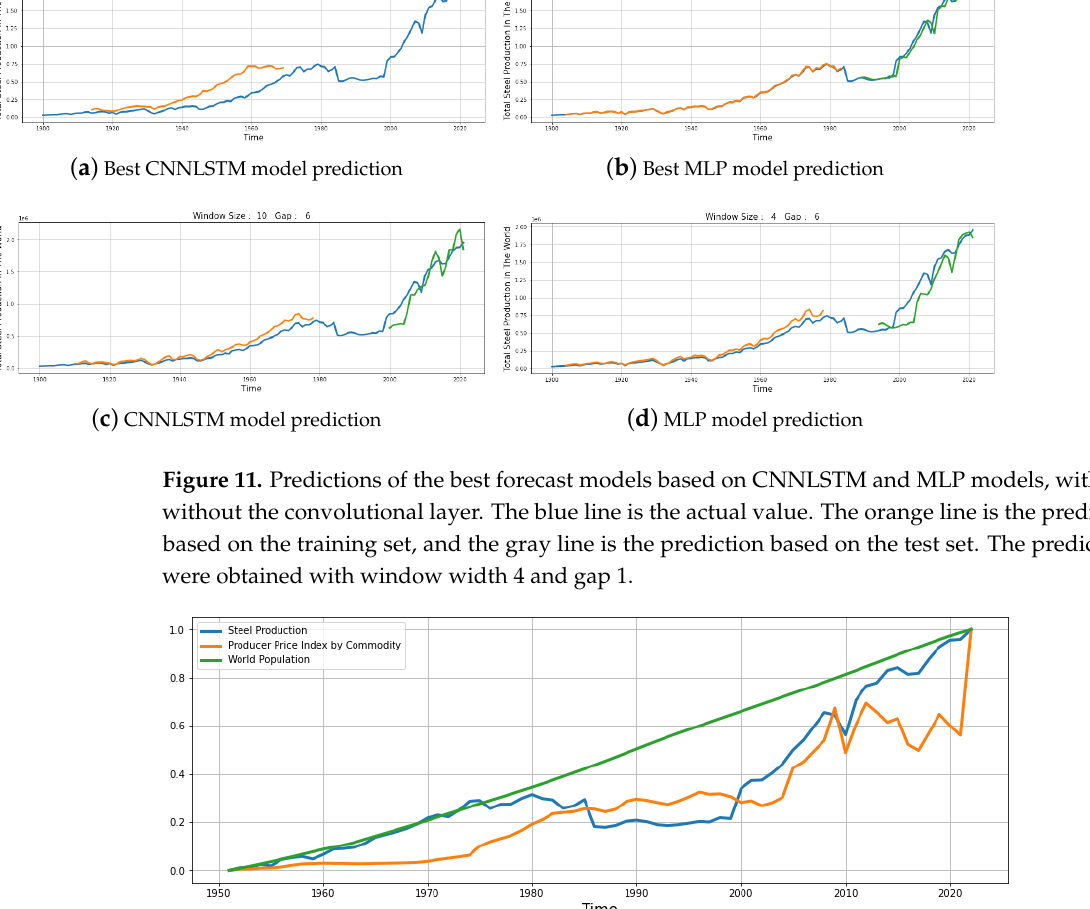
Figure 12. Steel production, producer price index by commodity, and world population in format time